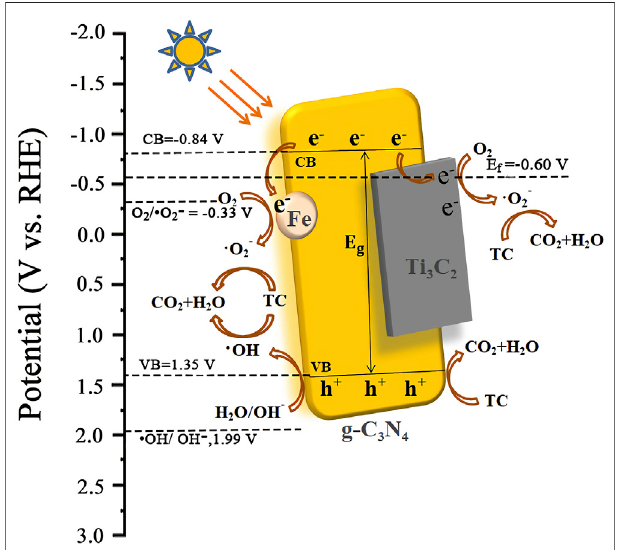
FIGURE 8 | Photocatalytic degradation mechanism diagram of Fe- C 3 N 4 /Ti 3 C 2 to TC.